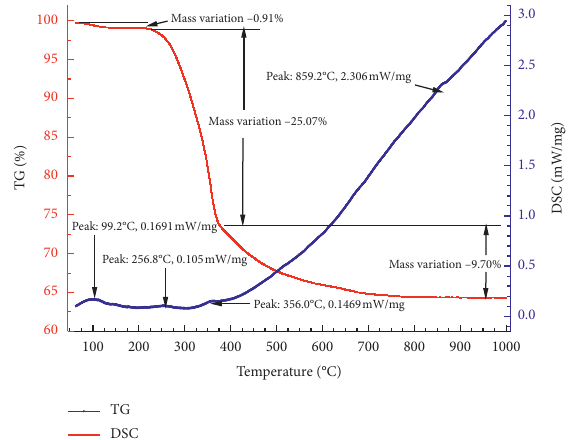
Figure 3: The thermal analysis spectra of the walnut shell powder treated with the silica sol.